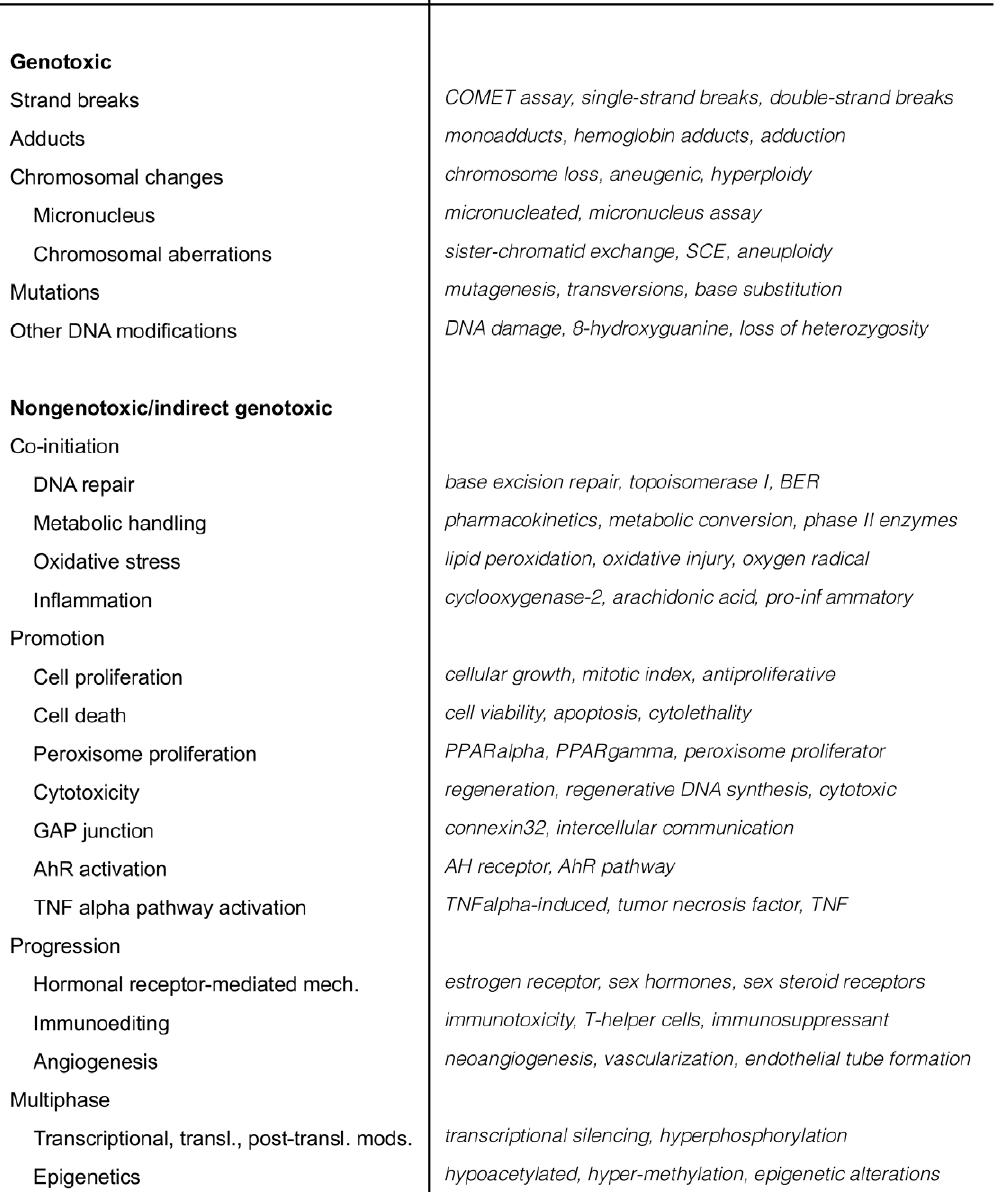
Figure 4. Example keywords for the ModeofAction taxonomy.